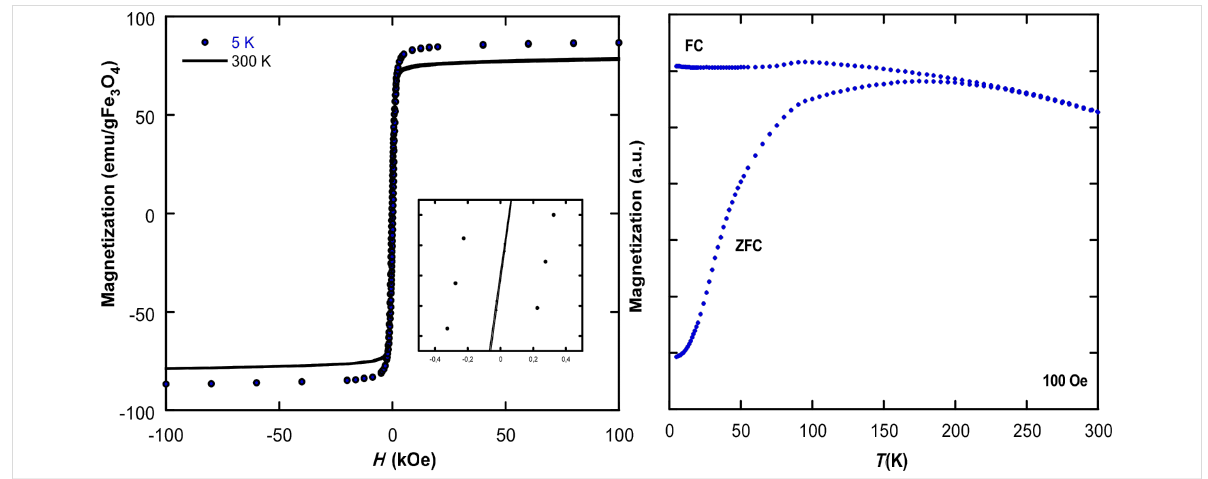
Figure 2: a) Experimental M vs H hysteresis cycles at 300 and 5 K and b) Magnetization of the zero-field-cooled (ZFC) and field-cooled (FC) Fe 3 O 4 @OA sample.